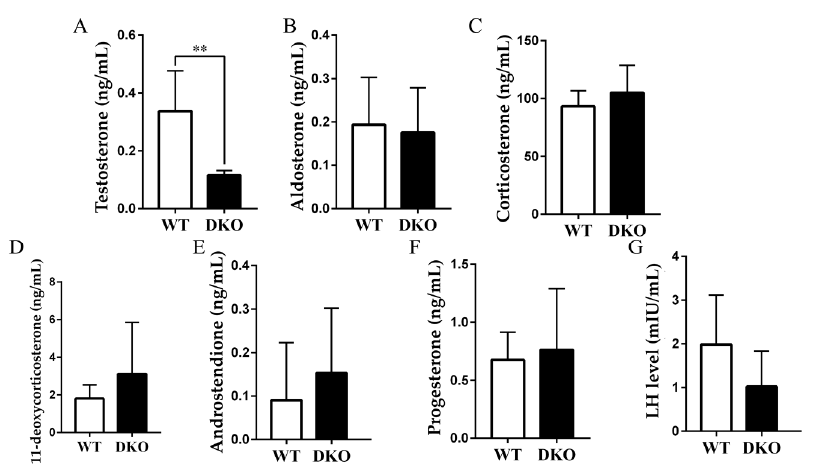
Figure 5. Plasma steroid hormone levels in 15-month-age WT and DKO male mice. ( A – G ): T, ALD, CORT, DOC, A4, P, LH ( n = 8). ** p < 0.01.